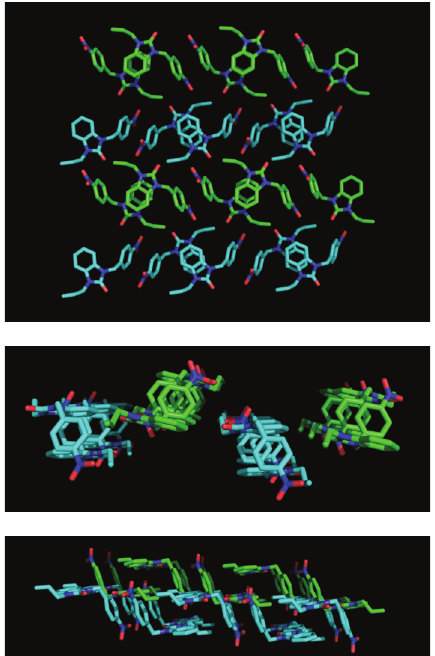
Figure 8: Observed arrays of parallel aromatic units involving nitrobenzene–nitrobenzene interactions (bc plane) highlighted in green and cyan.